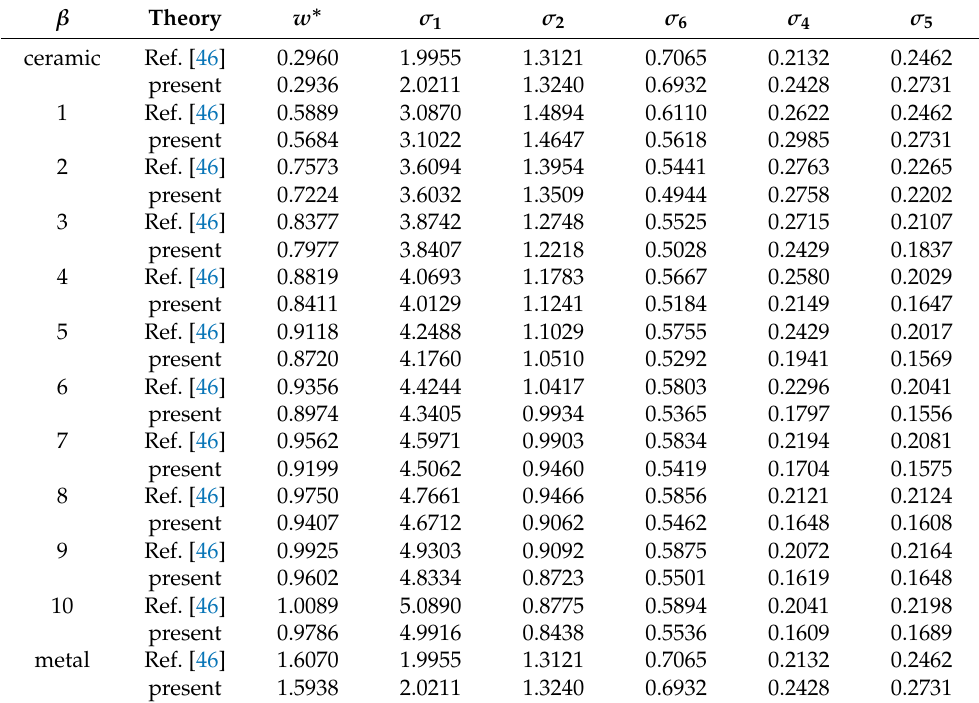
Table 3. Comparison of non-dimensional deflection and stresses of FG square plate under sinusoidal distributed load ( a = 10 h ).